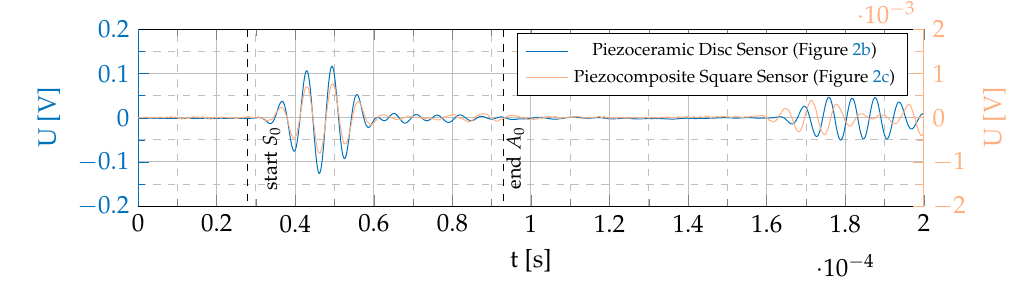
Figure 4. Exemplary signal comparison of a commercial piezoelectric disc sensor and a piezocompos- ite square sensor under GUW excitation. Dashed lines indicate the estimated start and end times of the faster S 0 and slower A 0 wave package, respectively, at the sensor location. ( a ) Excitation signal before amplification: 5-cycle hanning windowed sine burst ( f c = 150kHz). ( b ) Sensor signals.